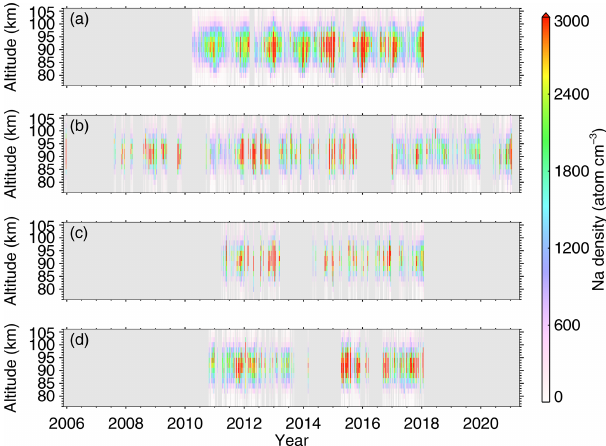
Figure 8. Time series of mean Na number density in a 5d × 2km average grid from Na lidars at (a) Beijing (40.5 ◦ N, 116.0 ◦ E), (b) Hefei (31.8 ◦ N, 117.3 ◦ E), (c) Wuhan (30.5 ◦ N, 114.4 ◦ E), and (d) Haikou (19.5 ◦ N, 109.1 ◦